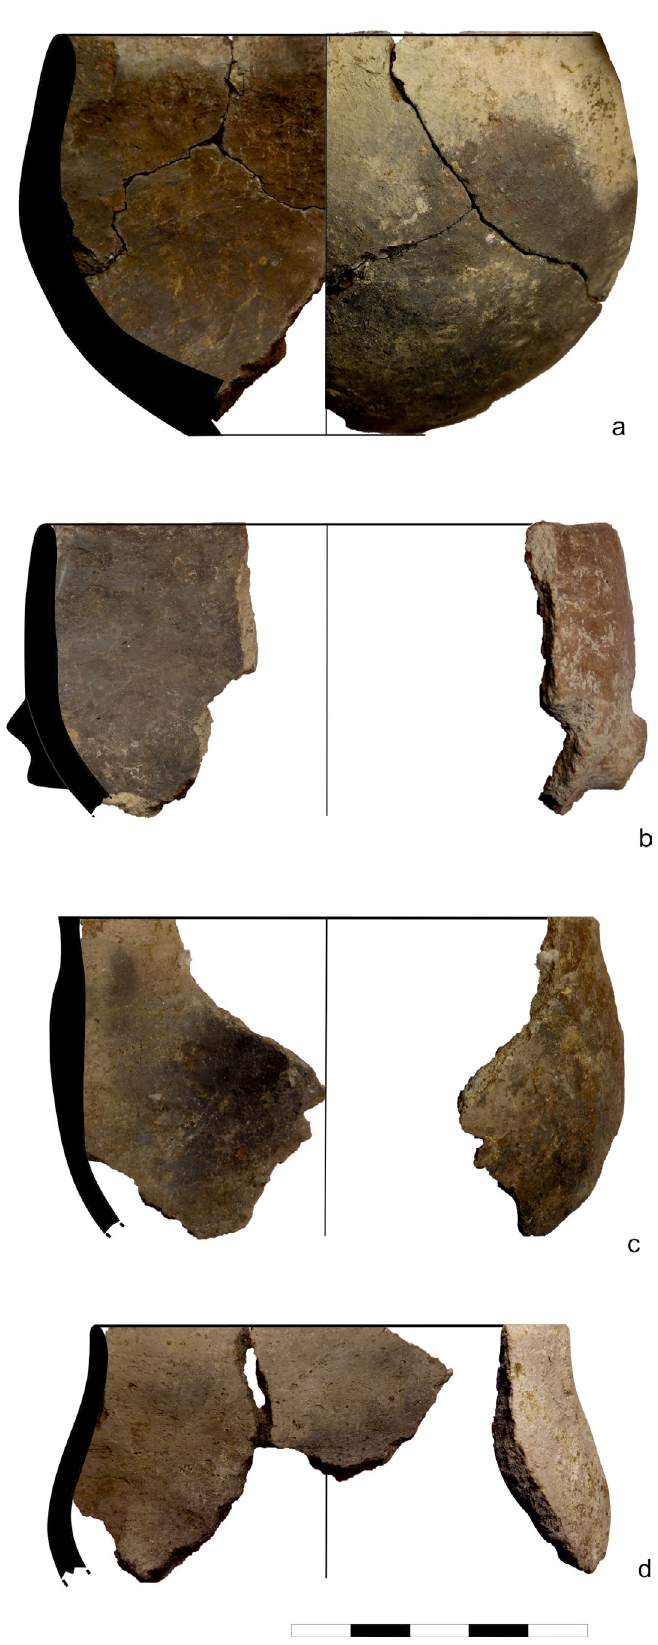
Figure 6. Open-shaped cooking pots from Stavroupoli: a) spherical vessel, b-d) hemispherical